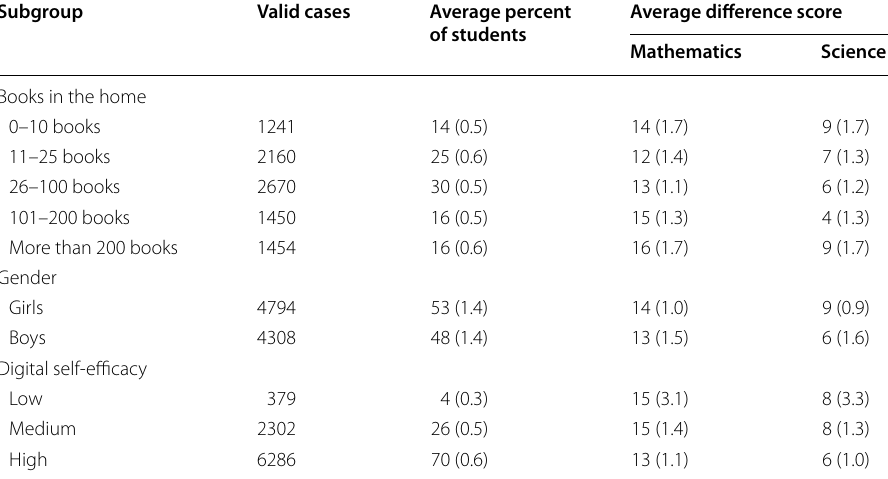
Table 9 Average paperTIMSS-eTIMSS difference scores by student subgroups—eighth